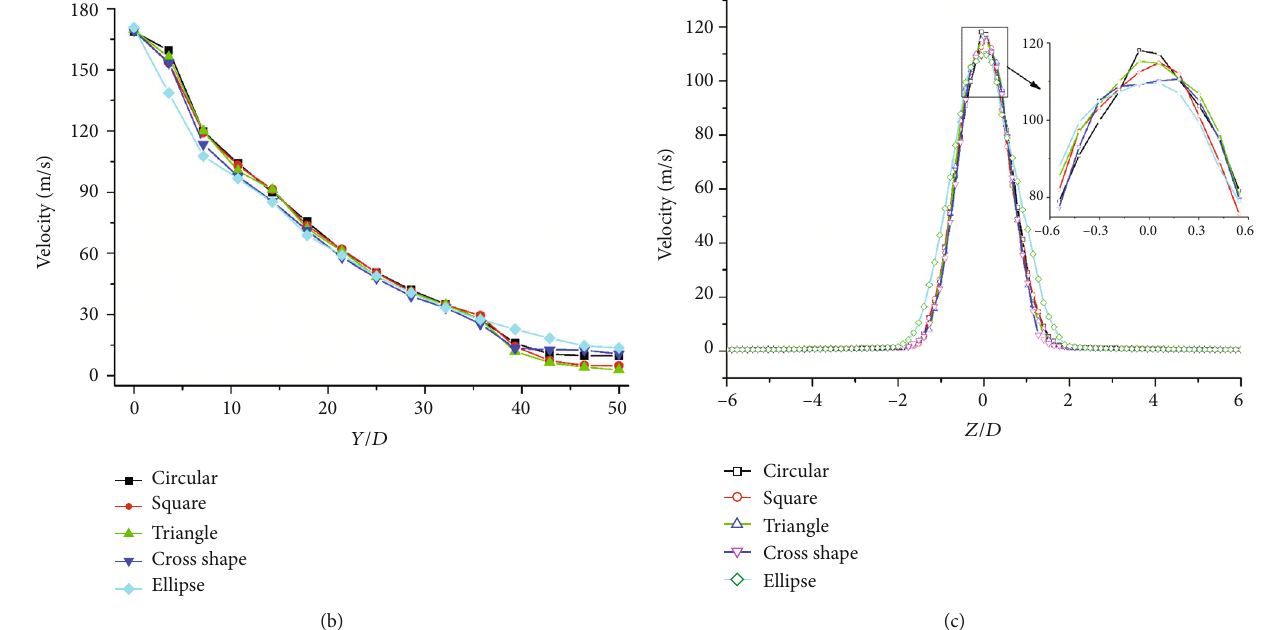
Figure 13: The velocity distributions of di ff erent water jets: (a) the velocity contours, (b) the axial velocity distribution, and (c) the radial velocity